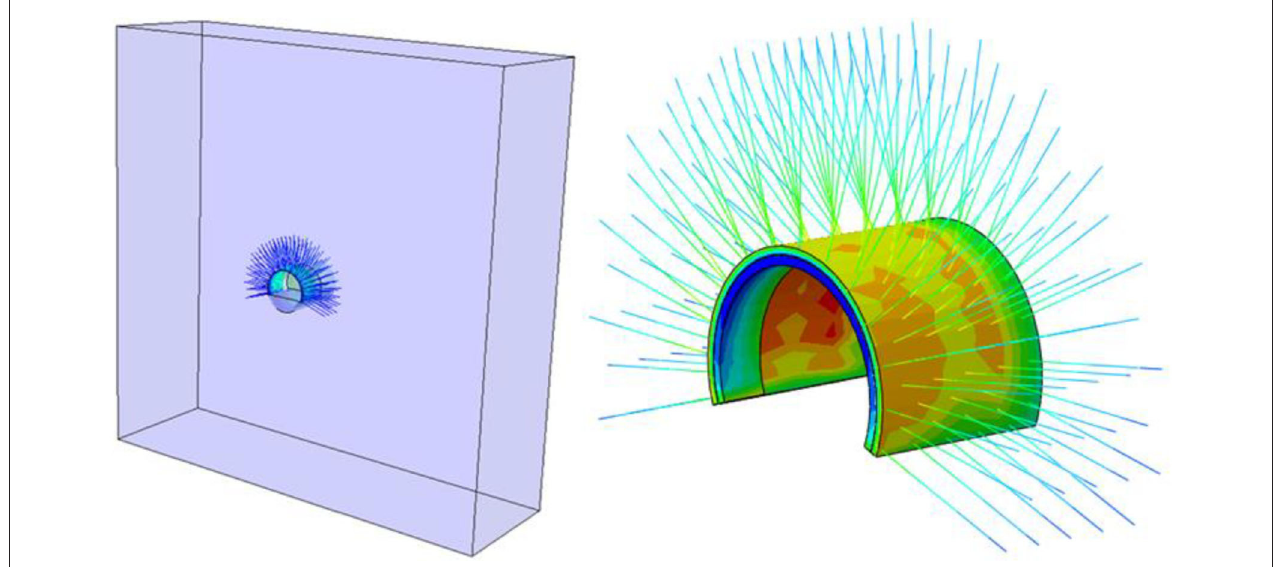
FIGURE 6 | The fifth construction step: excavation up to 12m, initial support construction up to 9m, and lining installation.